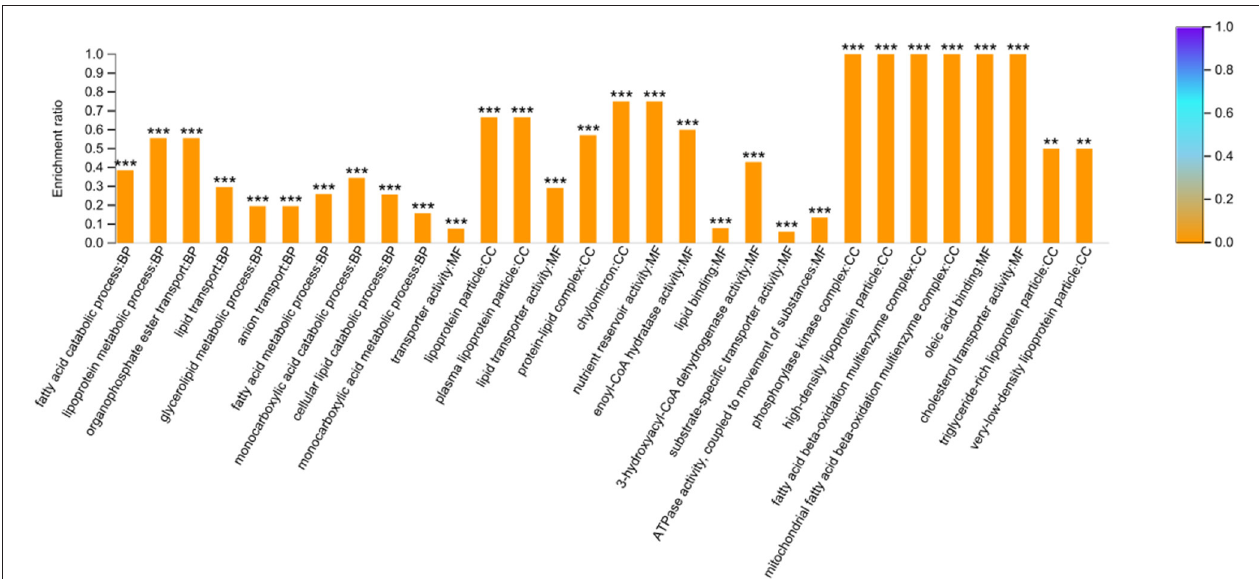
FIGURE 4 | GO enrichment analysis based on the 57 differentially expressed proteins related to fatty acid metabolism. The top 10 categories in biological process (BP), cellular component (CC) and molecular function (MF) were presented. The symbol *** and ** indicates the P -values < 0.001 and P -values < 0.01,